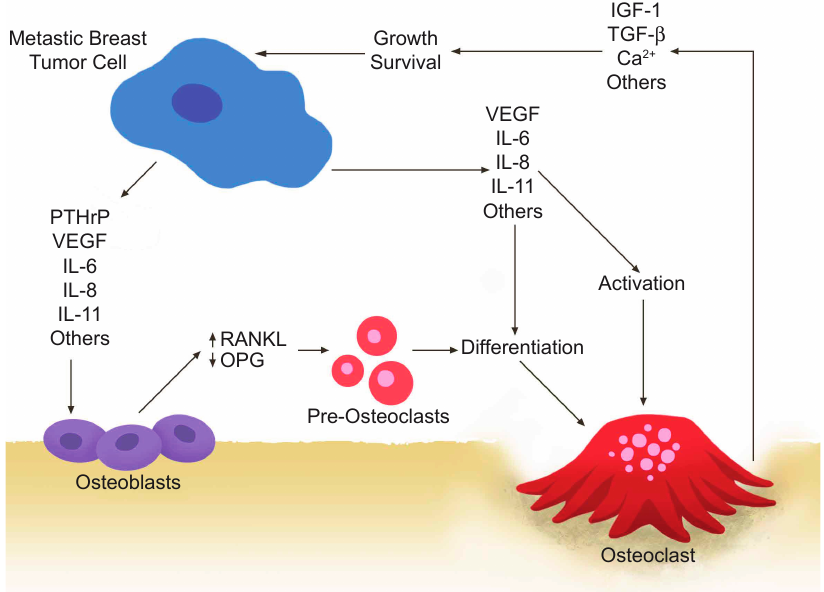
Figure 1. The vicious cycle of breast cancer bone metastases. Breast cancer cells secrete soluble factors, including parathyroid hormone-related protein (PTHrP), vascular endothelial growth factor (VEGF), interleukin (IL)-6, IL-8 and IL-11, which in the bone metastatic site act on osteoblasts and/or osteoclasts. The production of receptor activator of nuclear factor- κ B ligand (RANKL), an osteoclast differentiation factor, is increased and the production of osteoprotegerin (OPG) is decreased from osteoblasts. Late-stage pre-osteoclast cells respond to specific breast cancer-secreted factors by differentiation and osteolytic activation.